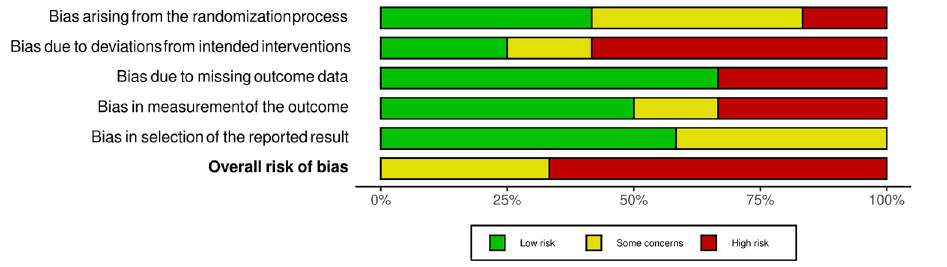
Fig 3. RoB 2 Summary plot of included studies